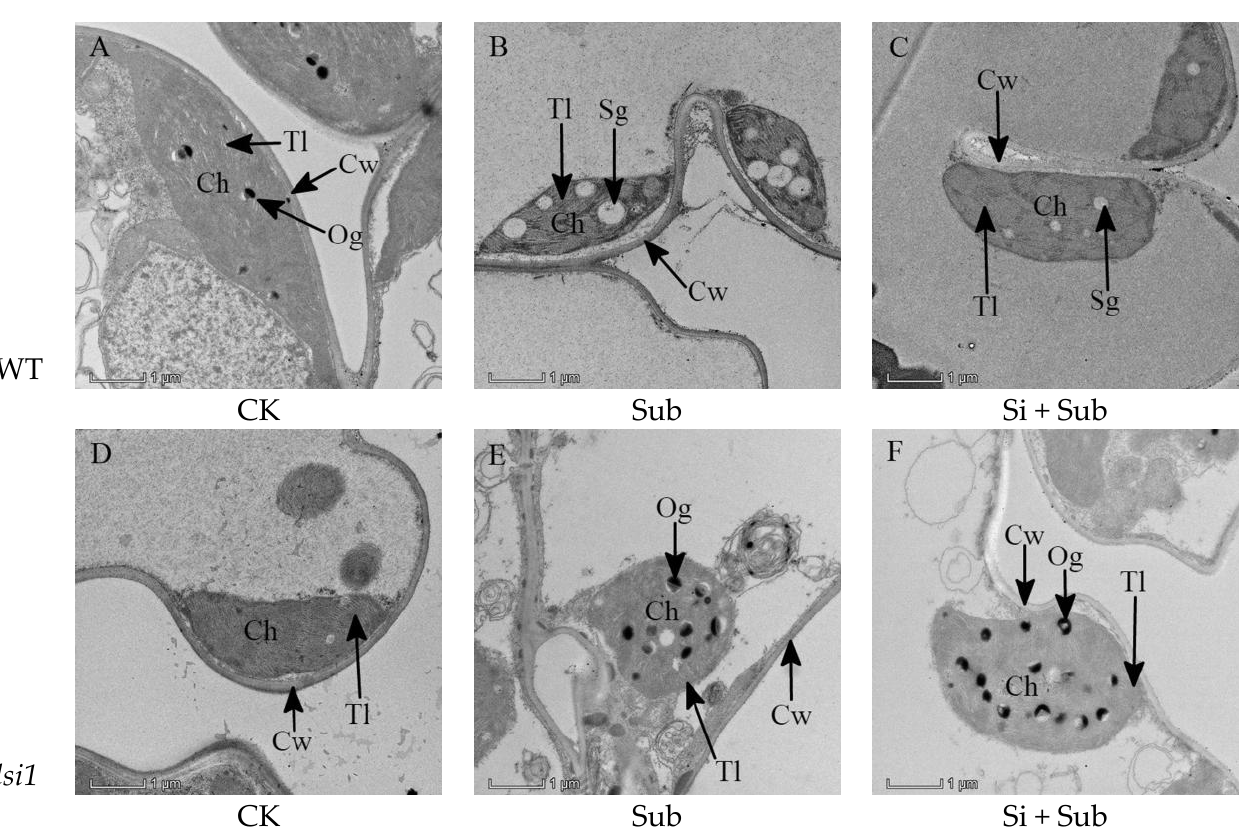
Figure 4. Effects of Si application on chloroplast ultrastructure in leaves under submergence stress ( × 8500, bar = 1 µ m). WT, wild type. ( A – C ), WT; ( D – F ), lsi1 ; ( A , D ), CK; ( B , E ), Sub; ( C , F ), Si + Sub. Ch, chloroplast; Cw, well wall; Tl, thylakoild lamella; Og, osmiophilic granules; Sg, starch grains.